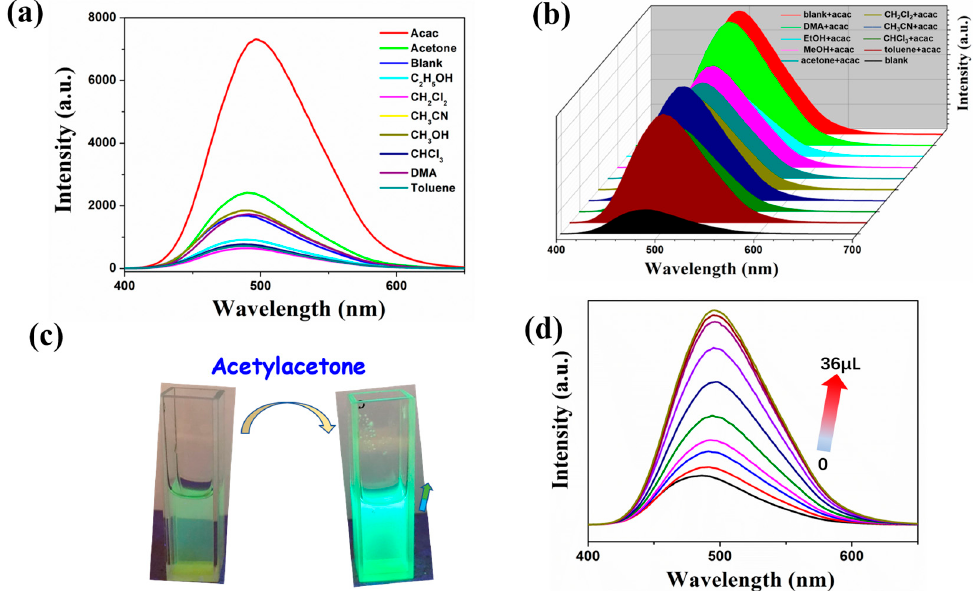
Figure 6. ( a ). Emission intensities of CdMOF-2 in DMF with different organic solvents (3000 ppm). ( b ). Anti-interference performance of CdMOF-2 for sensing Acac with the coexistence of other organic solvents (3000 ppm) in DMF solutions. ( c ). Sample of CdMOF-2 in DMF containing 3000 ppm Acac converted the visible emission color from blue to green (under 365 nm UV-lamp). ( d ). Emission intensities of CdMOF-2 with increasing concentrations of Acac (0–36 μ L) in DMF solution.